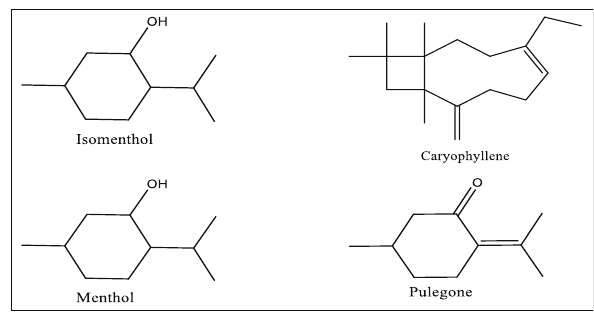
Figure 2: Molecular structure of the dominant phytochemicals in EOR.